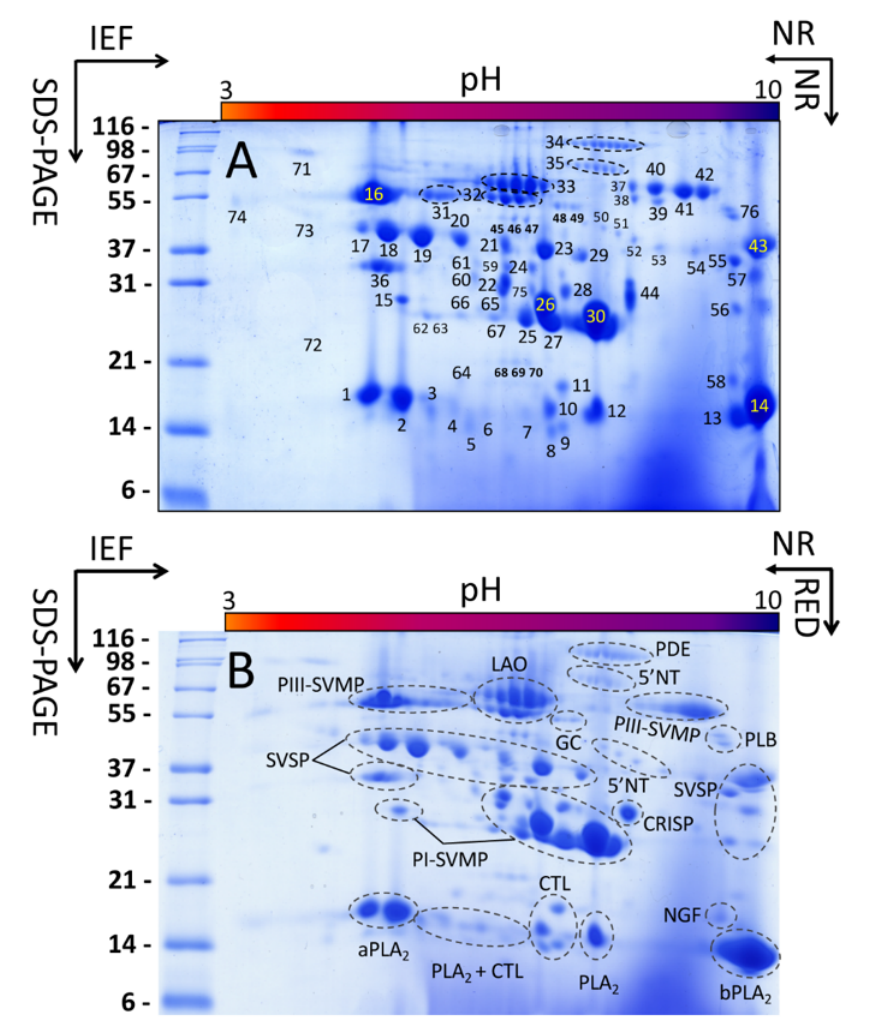
Figure 2. Two-dimensional gel electrophoresis of the Brazil’s lancehead venom proteome. Two-dimensional electrophoretic separations (IEF/SDS-PAGE) of the venom proteins of Bothrops brazili from Pará. For the first (IEF) dimension, the venom proteins were focused to their isoelectric points under non-reducing (NR) conditions. For the second (SDS-PAGE) dimension, the IPGs were equilibrated at room temperature in equilibration buffer (A) without (NR) or (B) with (RED) 40 mM of the disulfide bond reducing agent, DTT. (A) Spots submitted to in-gel trypsin digestion and bottom-up peptide-centric MS/MS analysis are numbered, whereas identified proteins are listed in Additional file 2. (B) An overview of the distribution of, and occurrence of proteoforms within, the different toxin classes identified in the venom of the Brazil’s